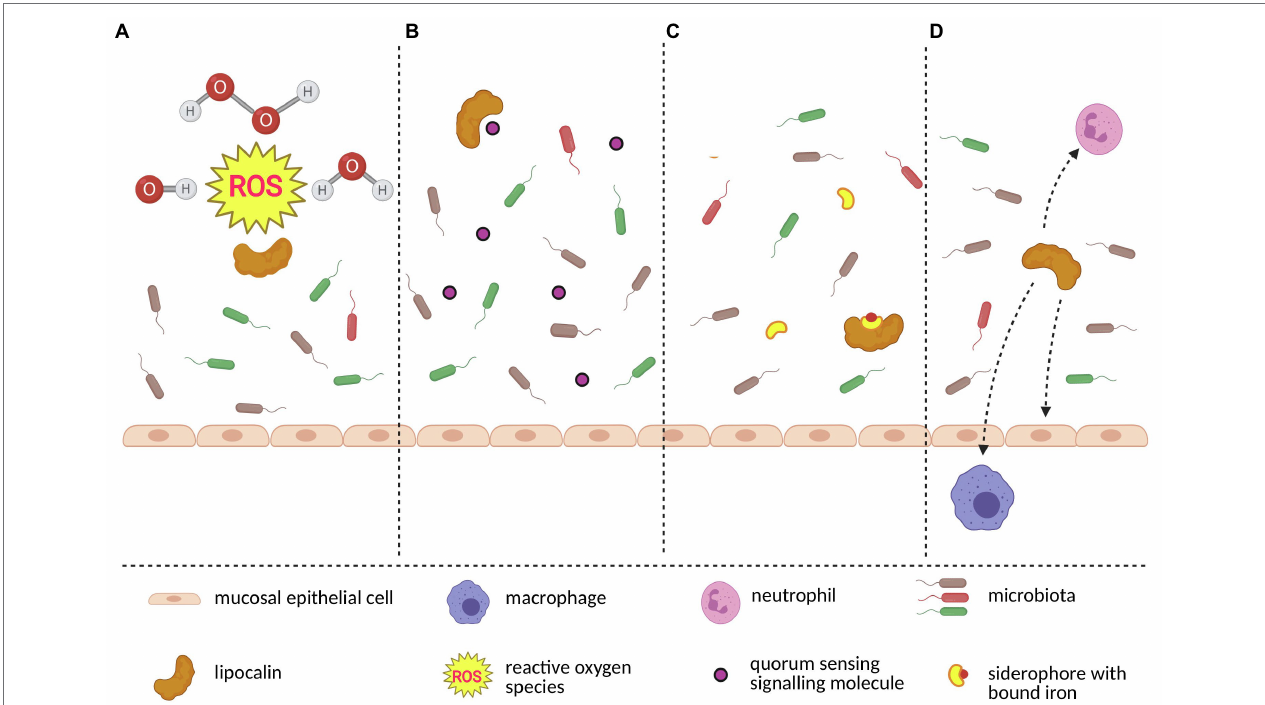
FIGURE 4 | A model of interactions between lipocalins and microbiota. Lipocalins protect host’s epithelial cells and also commensal microbiota by scavenging toxic molecules such as reactive oxygen species which originate during oxidative stress (A) . Keeping microbiome homeostasis requires blocking the origin of bacterial monoculture. Lipocalins contribute to diversified microbiome by scavenging bacteria-produced quorum sensing signalling molecules (B) . Similarly, certain bacterial species use siderophores to gain iron and subseuently outcompete siderophore-lacking bacteria. By binding to siderophore-iron complex, lipocalins further contribute to stable microbiome (C) . Finally, lipocalins closely interact with other members of the immune system network (i.e., neutrophils, macrophages and epithelial cells) and together create a complex microbiota-surveillace system (D) . The figure was created in